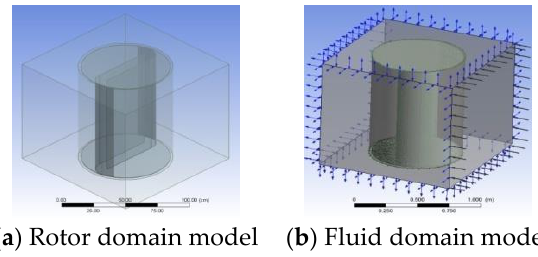
Figure 7. Main analysis domains.